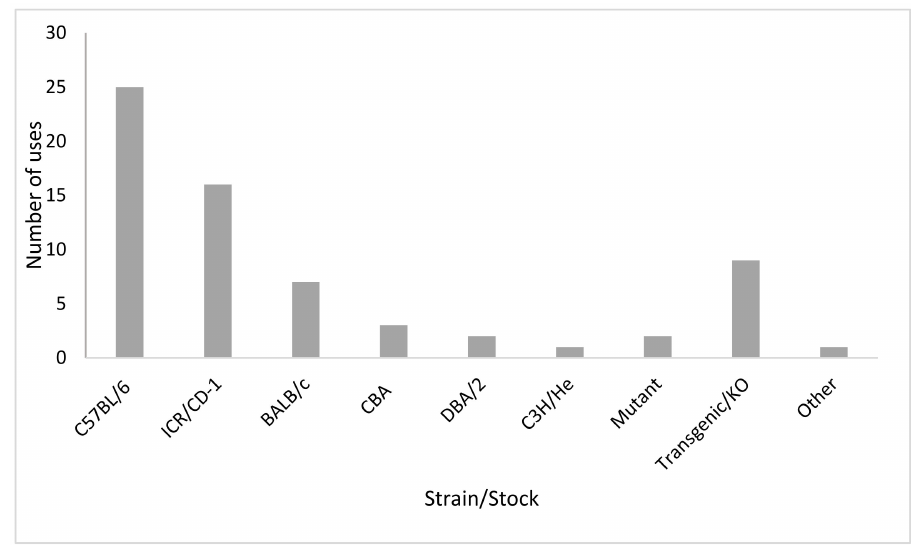
Figure 5. Representation of the different mouse strains and stocks used in the published papers. Note that a number of papers used more than one strain. The ICR and CD-1 nomenclature has been considered to represent the same stock. Other includes hybrid or recombinant strains.